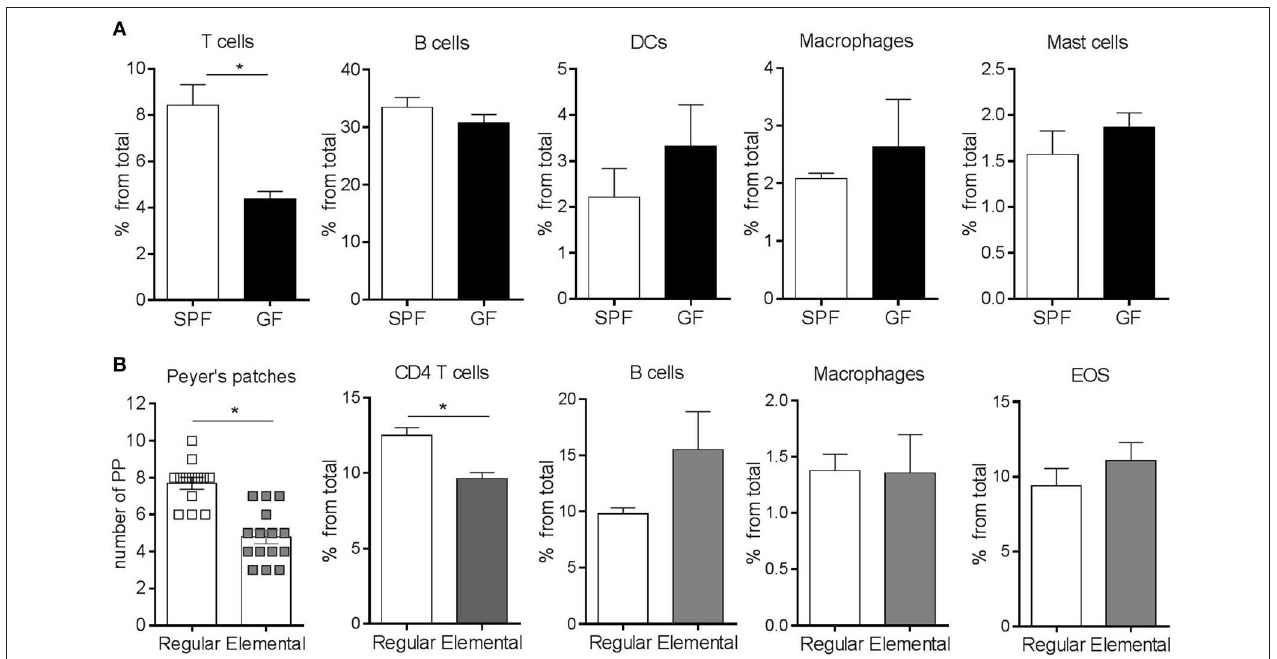
FIGURE 3 | Flow cytometric characterization of adaptive and innate immune compartments (A,B) in the small intestine of GF and SPF mice fed a regular (A) or elemental diet (B) . Pooled data from 2 to 4 experiments ( n = 6–22) represented as mean ± SEM, * P < 0.05.